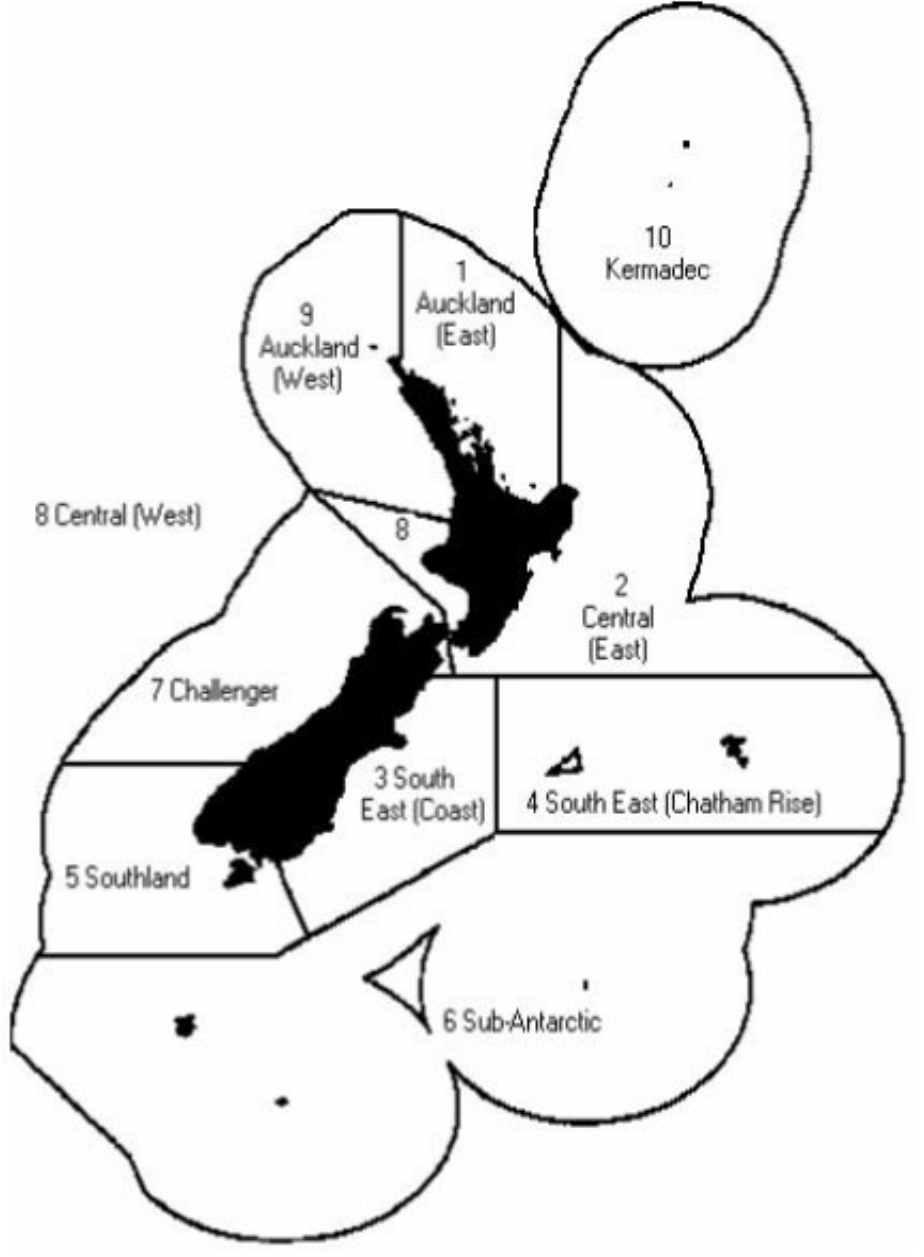
Fig. 1. New Zealand’s economic exclusion zone and quota management areas. Source: Ministry of Fisheries